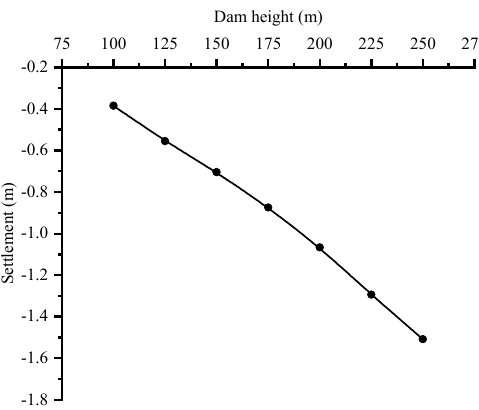
Appl. Sci. 2019 , 9 , x FOR PEER REVIEW Figure 8. Relationship between settlement maximum of ACC and dam height. Figure 8. Relationship between settlement maximum of ACC and dam height .